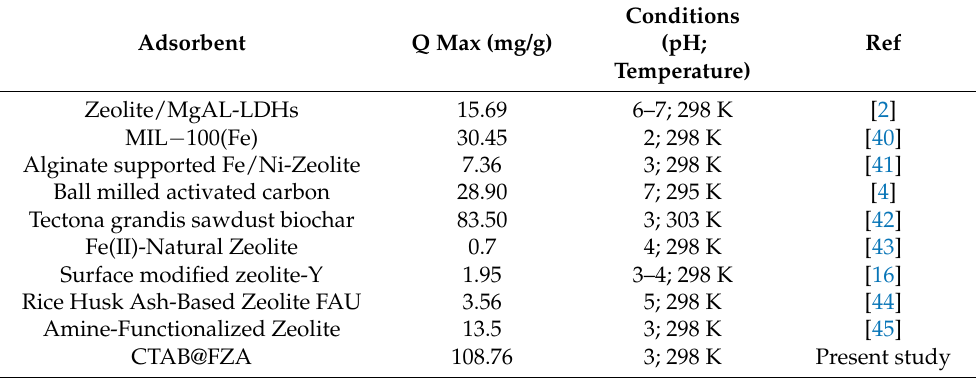
Table 4. Comparison of Cr(VI) sorption by different reported